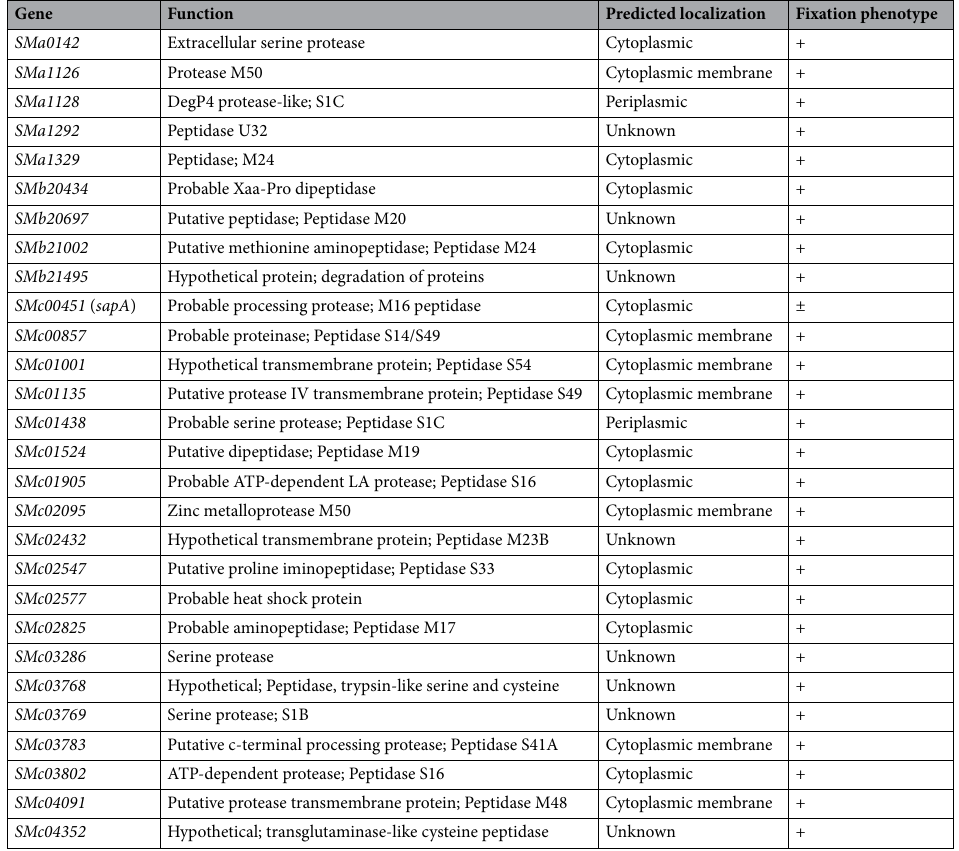
Table 1. Putative peptidases screened in M. truncatula A20 plants in this